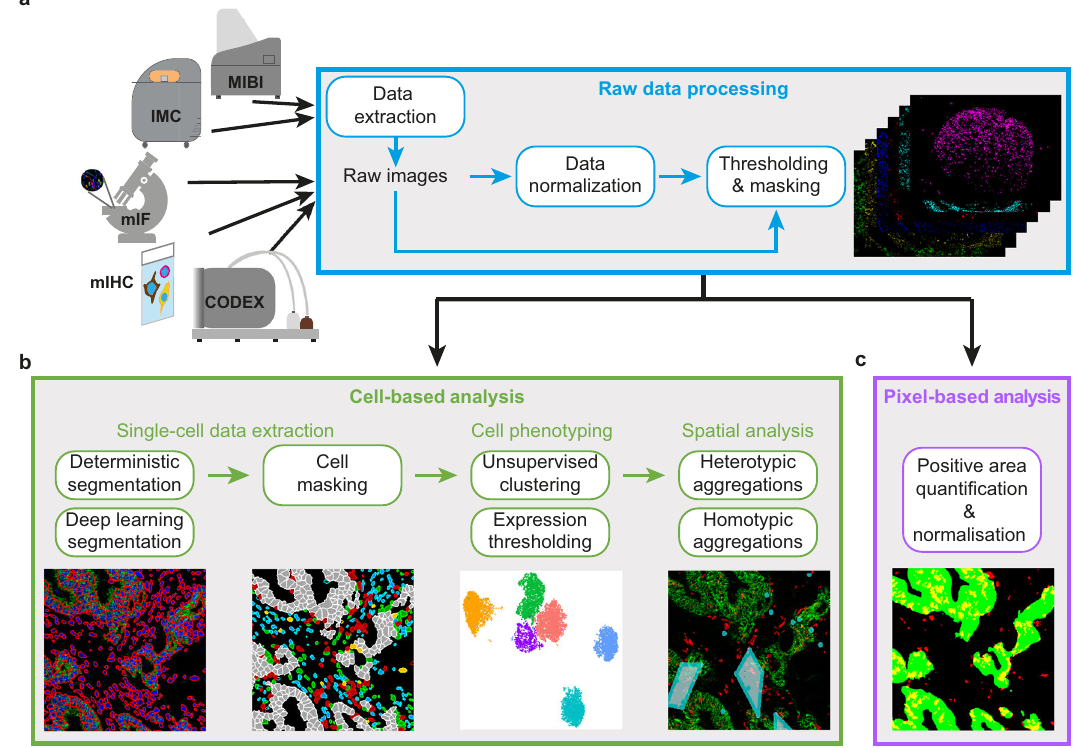
Fig. 1 Schematics of the SIMPLI work fl ow. a Raw images are extracted from IMC or MIBI data or directly imported from other imaging technologies. After their optional normalisation, these images are thresholded to remove the background noise and produce tissue compartments or marker masks. The resulting images can be analysed using a cell-based or a pixel-based approach. b In the cell-based analysis, single cells are segmented with deterministic or deep learning models and phenotyped using unsupervised or supervised approaches. The distribution of cells in the tissue can then be investigated through a spatial analysis of homotypic or heterotypic aggregations. c In the pixel-based approach, areas positive for a user-de fi ned combination of markers are measured and normalised over the area of the whole image or of the masks de fi ning compartments or areas positive for certain